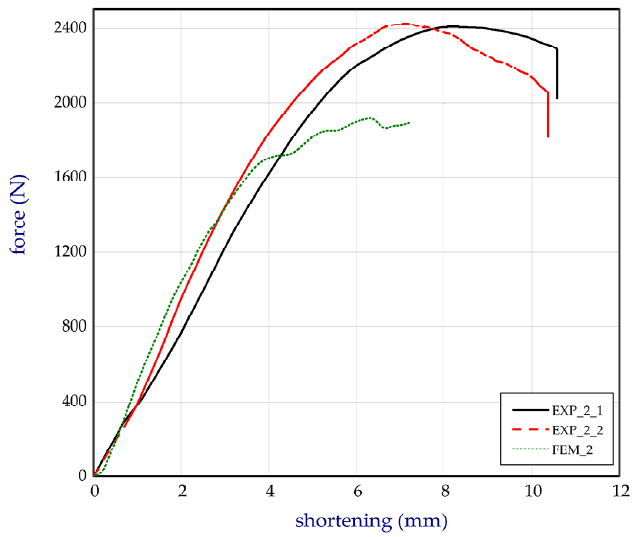
Figure 11. Total force of compression in a function of shortening for the basic model.